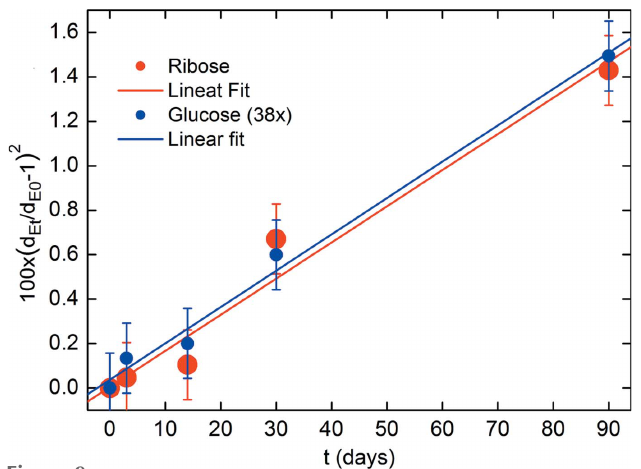
Figure 9 Squared relative variation of the equatorial period d E at the incubation time t , denoted by d Et , with respect to the value at t = 0, denoted by d E0 . This ratio is a measure for the variation of the equatorial in-plane areal density of collagen molecules as a function of the incubation time. Please note that the glucose data have been multiplied by a constant factor of 38.